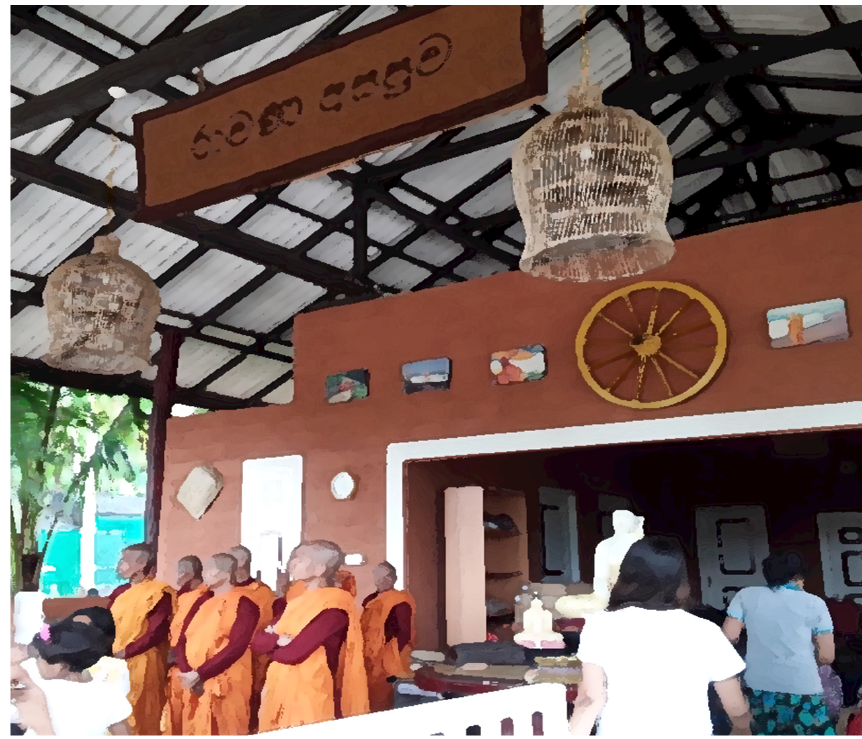
Figure 5. Bhikkhun¯ı -s at Ravana asapuwa . Photo by author. 19 October 2019, Umandawa Monastery, Figure 5. Bhikkhun ī -s at Ravana asapuwa . Photo by author. 19 October 2019, Umandawa Monastery, Kurunegala.